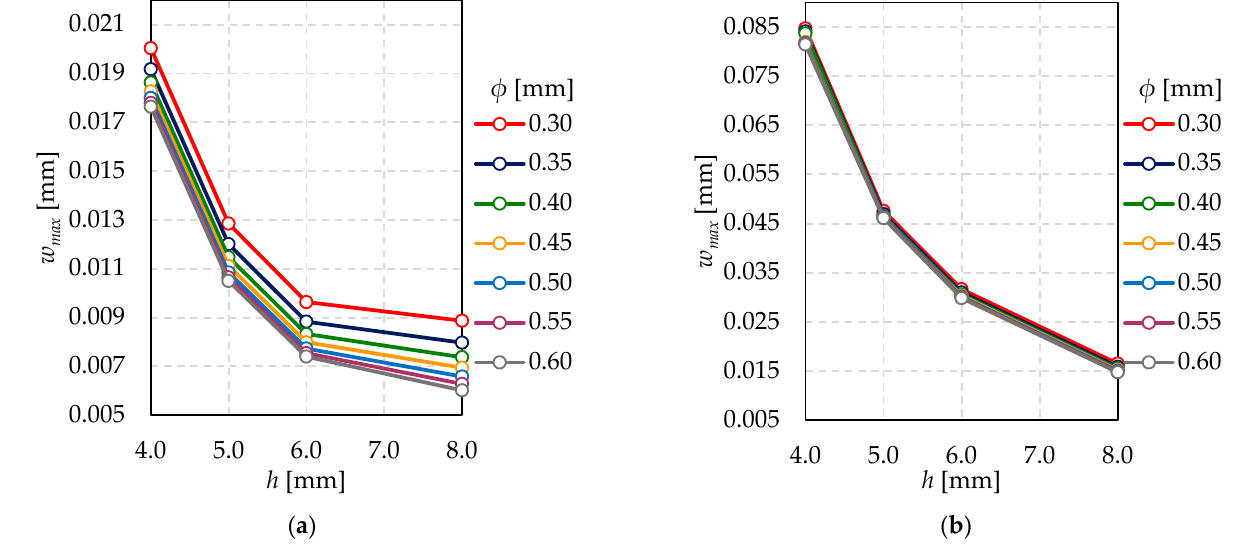
Figure 11. The relationship between maximum glass deflection ( w max ) and glass panes thickness ( h ) for different pillar diameter ( ϕ )—( a ) x 0 = y 0 = 50 mm; ( b ) x 0 = y 0 = 100 mm.